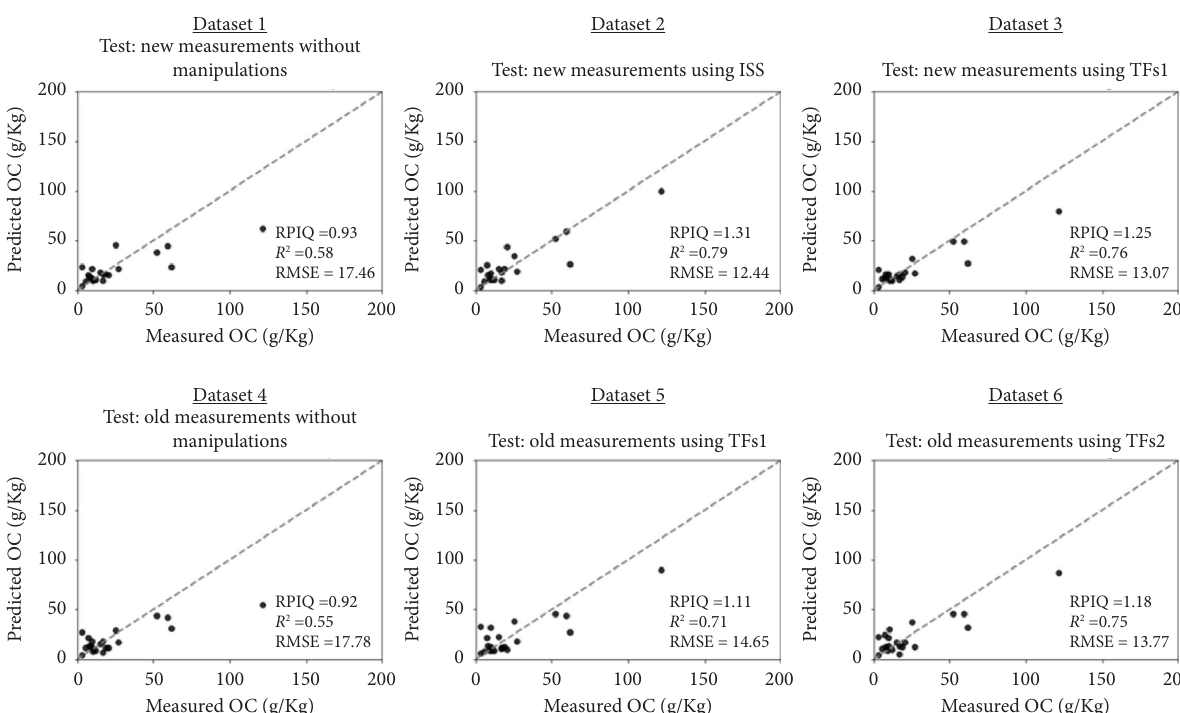
Figure 8: Te spectral-based models for OC content in the validation set with their respective reference numbers (Table 1) using the new and old–original spectral measurements of the rectifcation group.